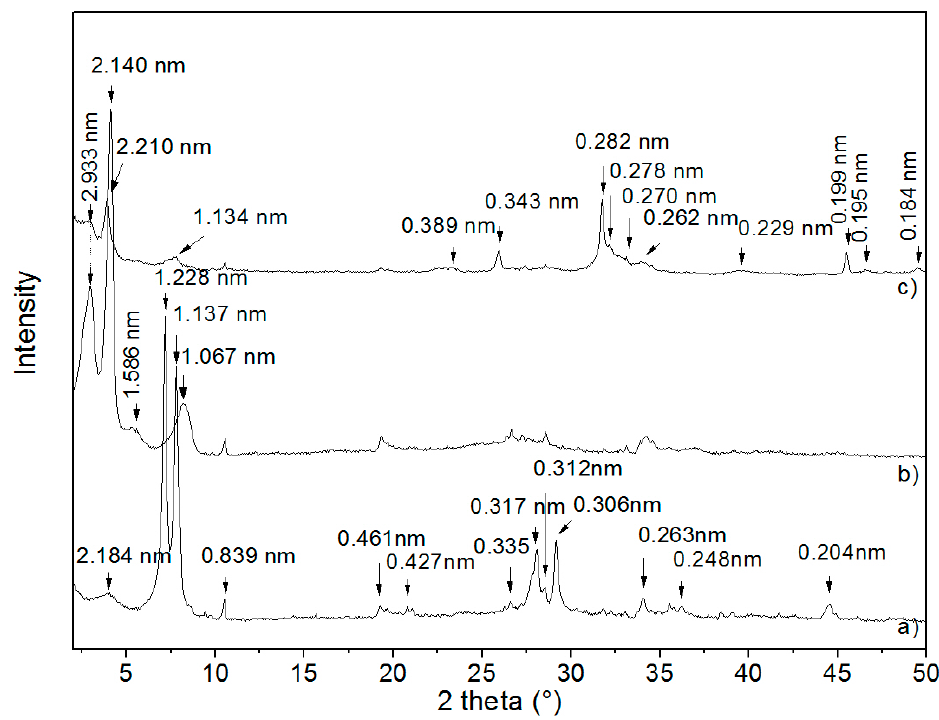
Figure 1. XRD patterns of VER samples ( a ) NaVER; ( b ) VCA; ( c ) VCAH at CuK radiation.